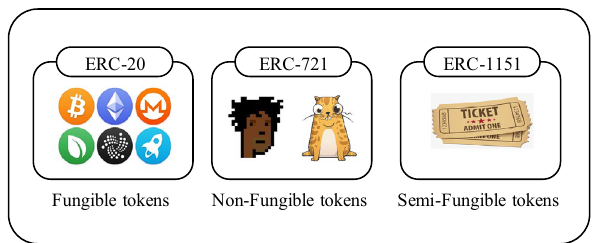
Figure 1. From right to left (fungible, non-fungible,